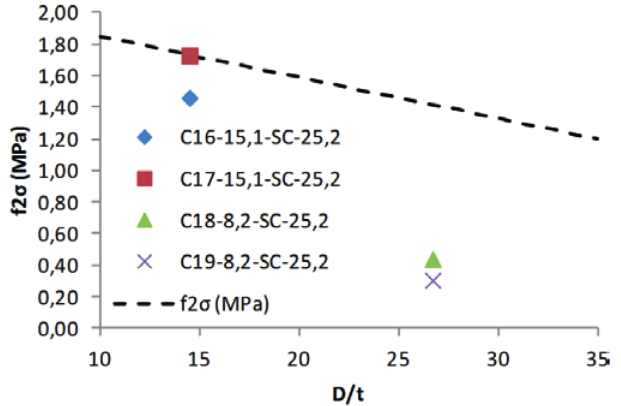
Figure 18 Comparison between curve f2 σ in function of D/t ratio, and the variation of the experimental natural bond stress for the tested models